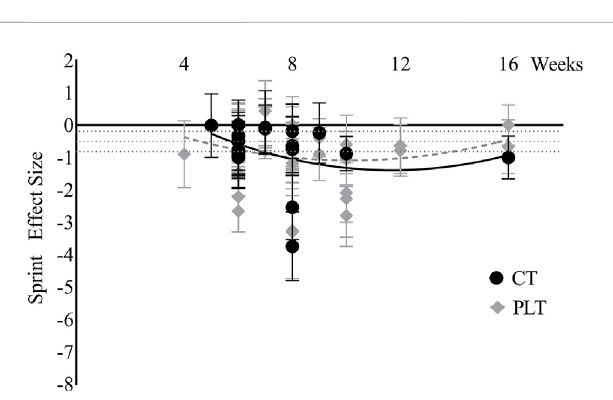
FIGURE 8 Jump ability changes over time (CT = complex training, PLT = plyometric training).